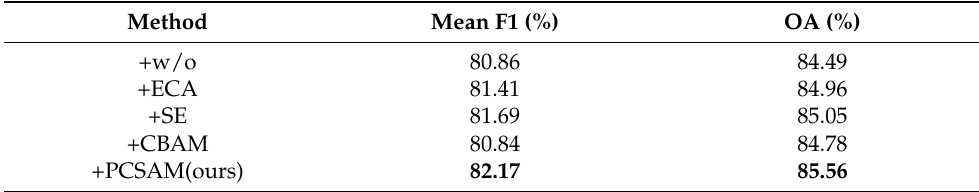
Table 2. Ablation experiments on different attention comparisons, the w/o indicates no PCSAM. The bold indicates the best data.